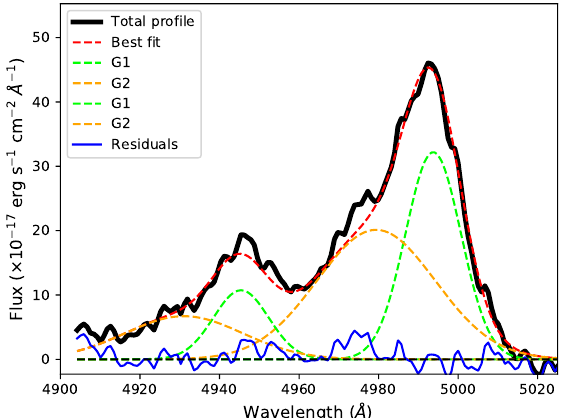
Figure 1. [O III] line fitting of the source J1114+3241. The black solid line represents the restframe spectrum after continuum and Fe II subtraction, the green dashed line represents the [O III] core components, the orange dashed line represents the wing components, and the best fit is shown as the red dashed line. The blue solid line shows the residuals, and the black horizontal dashed line corresponds to a zero-level